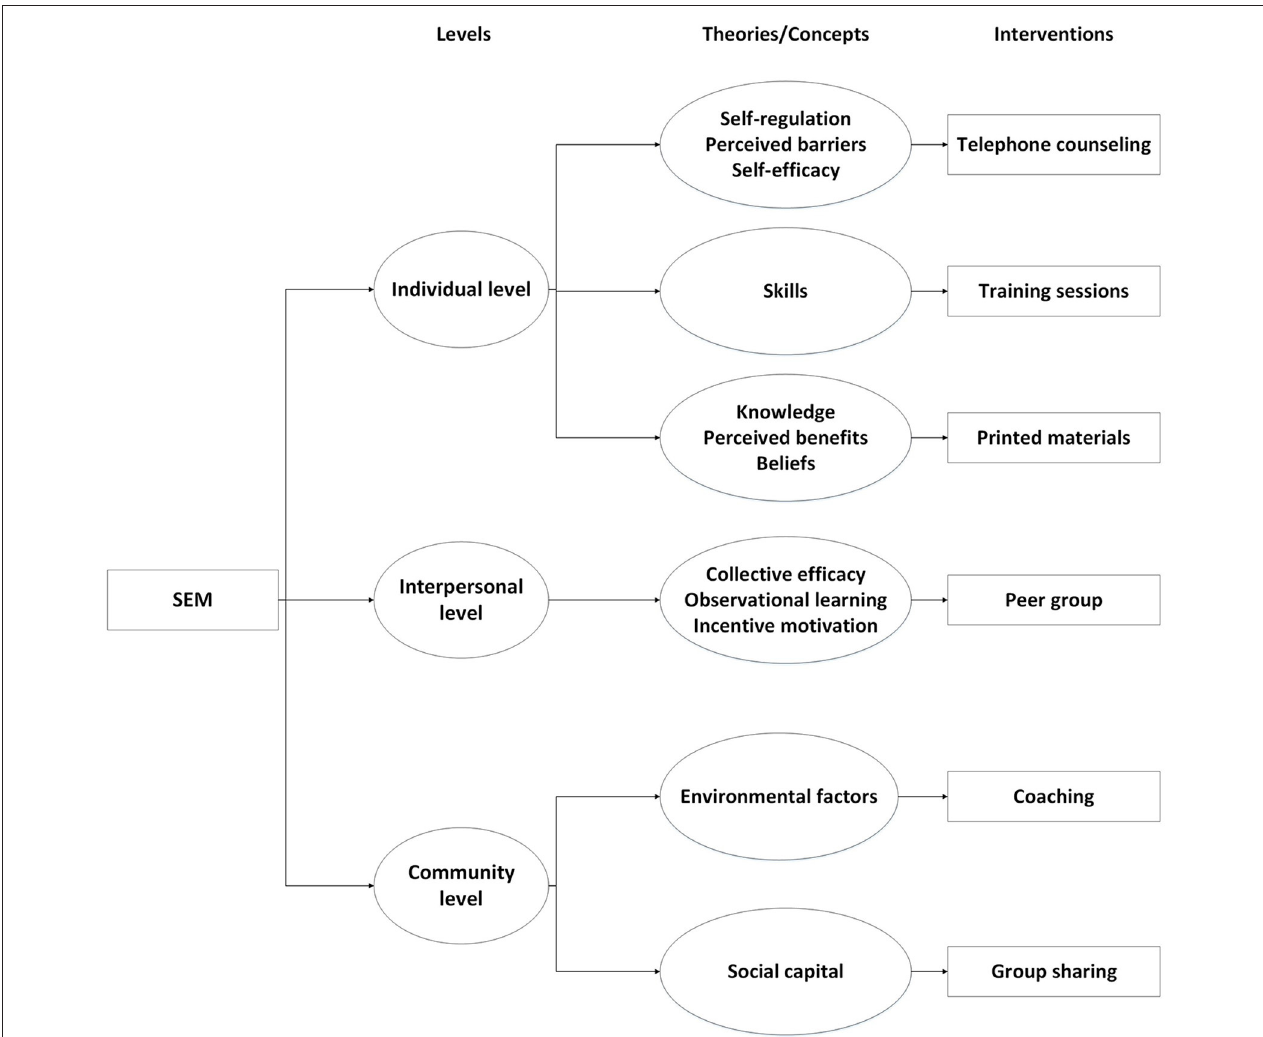
FIGURE 1 | Intervention strategies based on